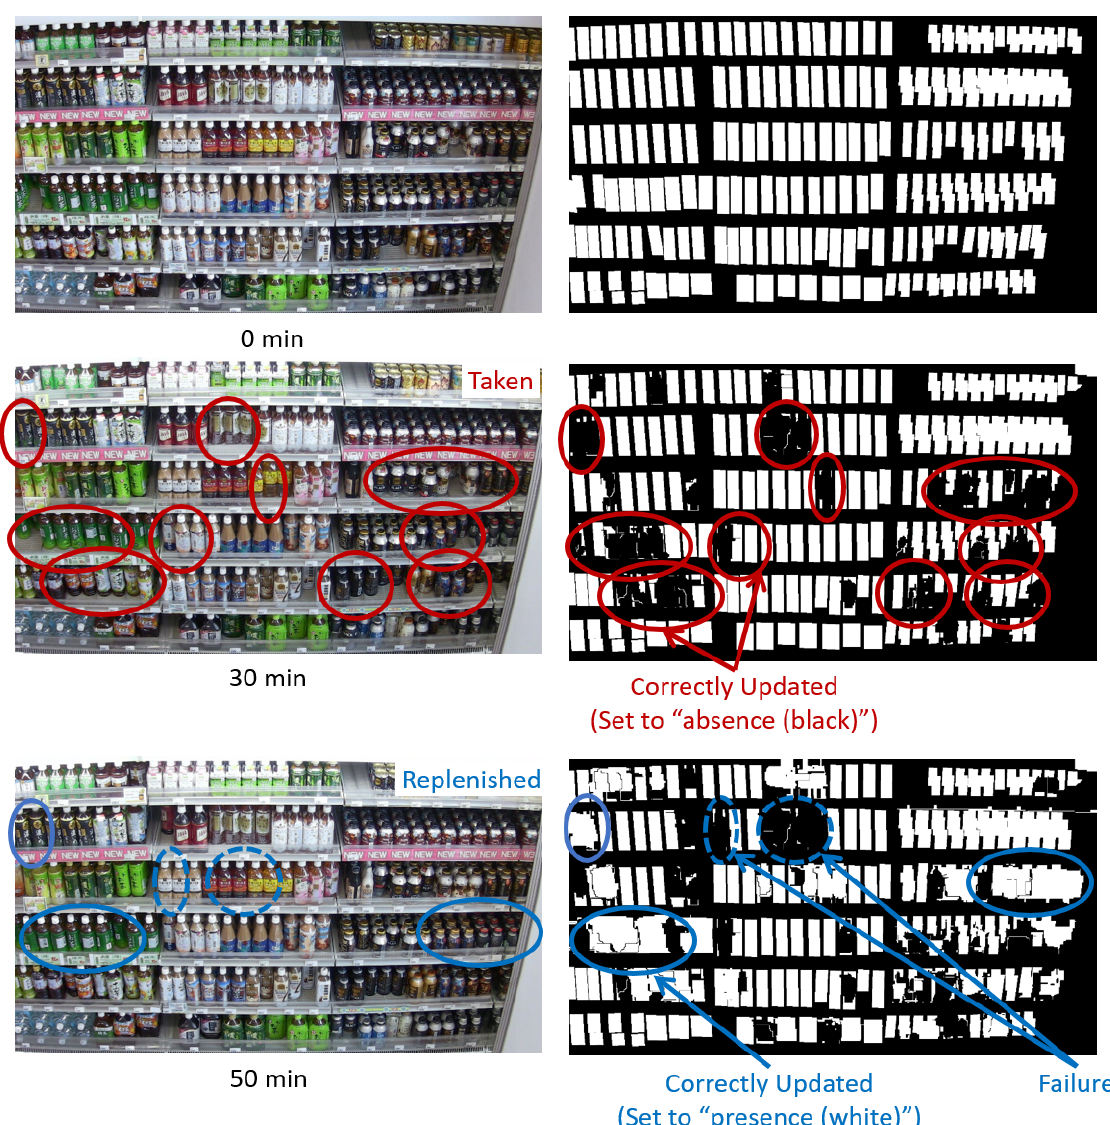
Figure 19. Some results for updated shelf condition in video